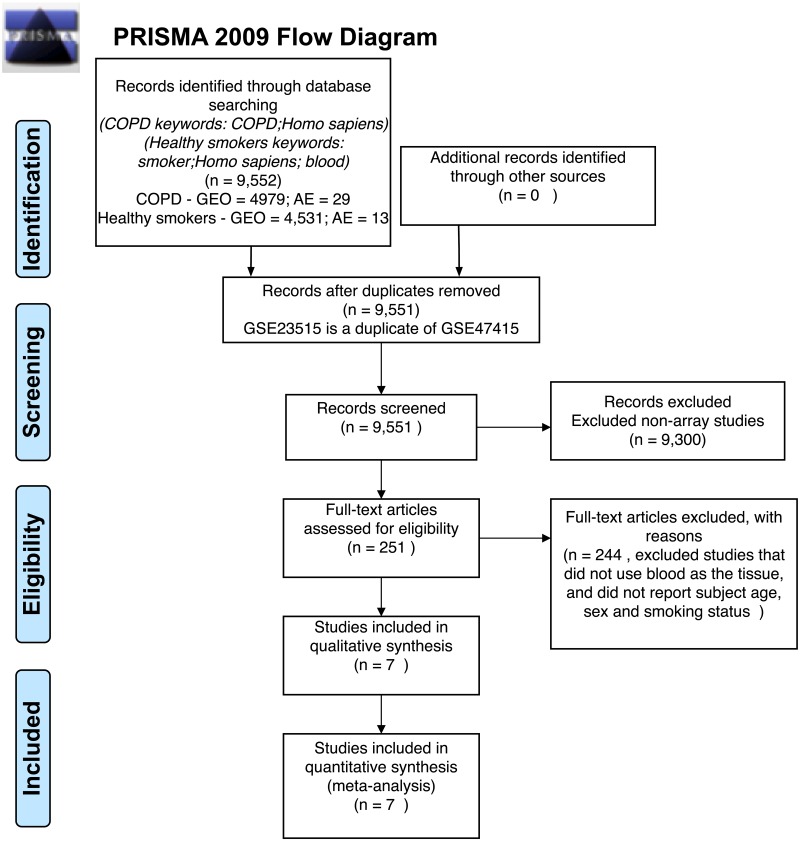
Preferred Reporting Items for Systematic Reviews and Meta-Analyses (PRISMA) flow diagram.Data were curated from Gene Expression Omnibus (GEO) and Array Express (AE). The PRISMA flow diagram shows the identification, screening, eligibility and inclusion of samples in our analysis.